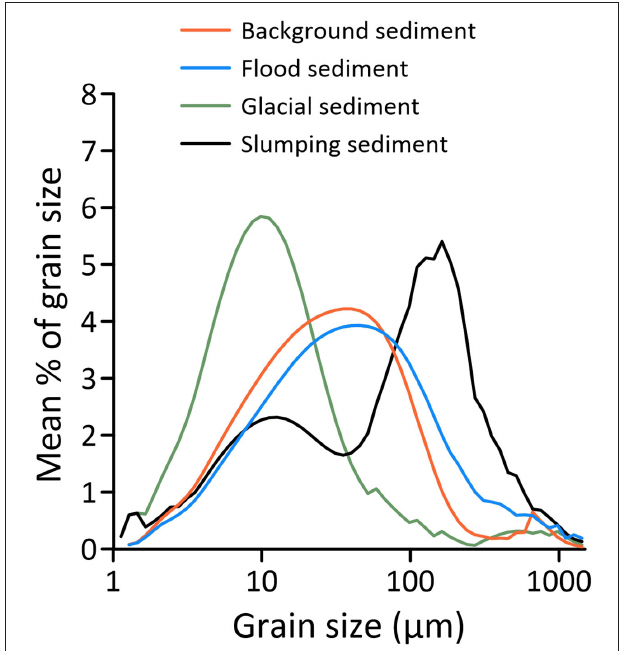
FIGURE 6 | Mean grain size distributions for four sedimentary classes based on interpretation of the sedimentology and magnetic susceptibility (MS; sections Core SA16/17 and Sediment Sources): (i) background sediments, (ii) flood sediments (high MS), (iii) glacial sediments (clay, low MS), and (iv) sediments associated with slumping events (sand, low MS).